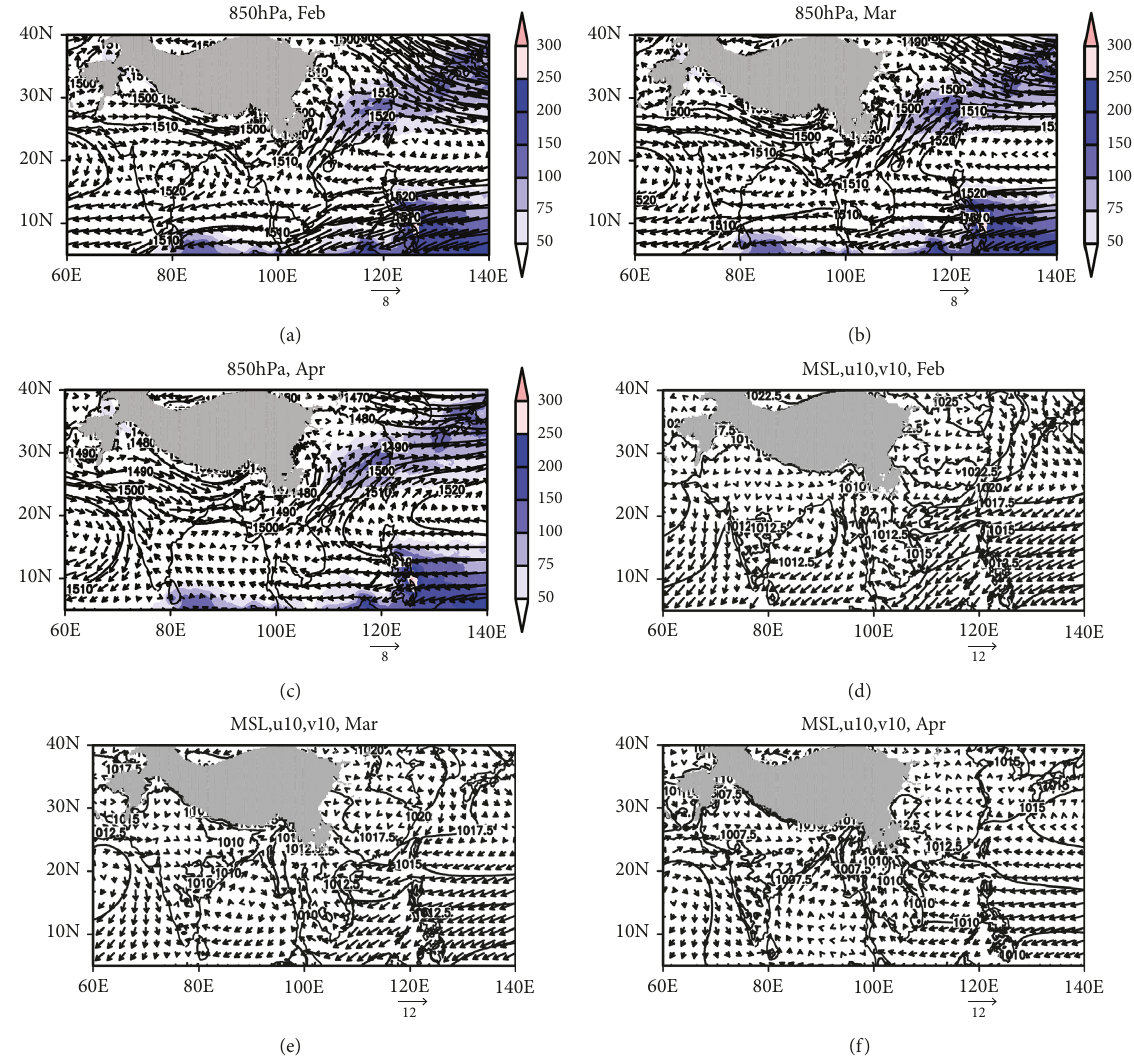
Figure 3: Climatology mean of rainfall ( shaded , mmmonth − 1 ), 850hPa wind ( vector , ms − 1 ), geopotential height ( contour , (m) ( a–c) and mean sea level pressure (contour, m), and 10m wind ( vector , ms − 1 ) (d–f). The areas where the land elevation is higher than 1500m are shaded